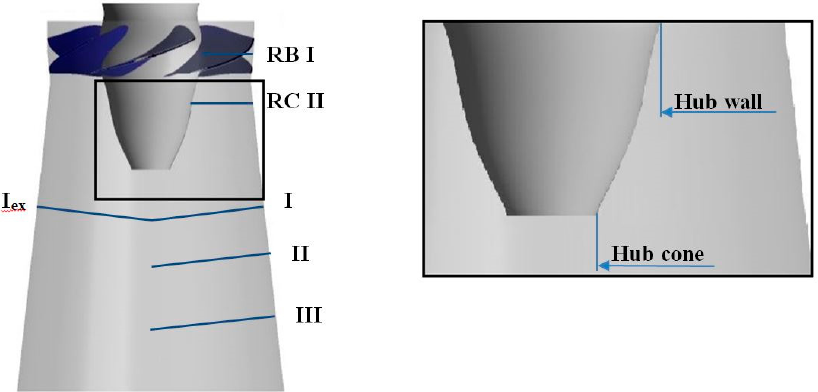
Figure 2. Pressure sensors location on the wall of the draft tube cone. ( a ) The positions are marked by blue dots. ( b ) Circumferential positions.